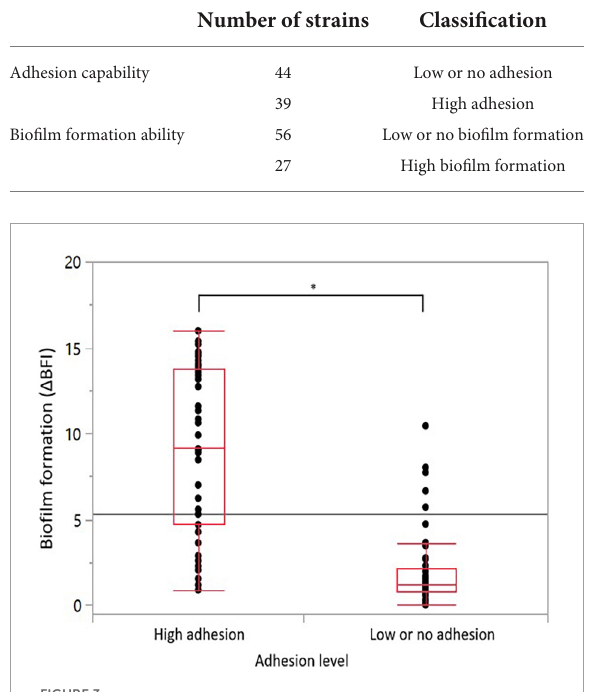
FIGURE3 Correlations between adhesion capability and biofilm formation ability. Distribution of the 83 C. jejuni strains biofilm formation according to their adhesion capability. Statistical significance was determined using the ANOVA test ( ∗ p ≤